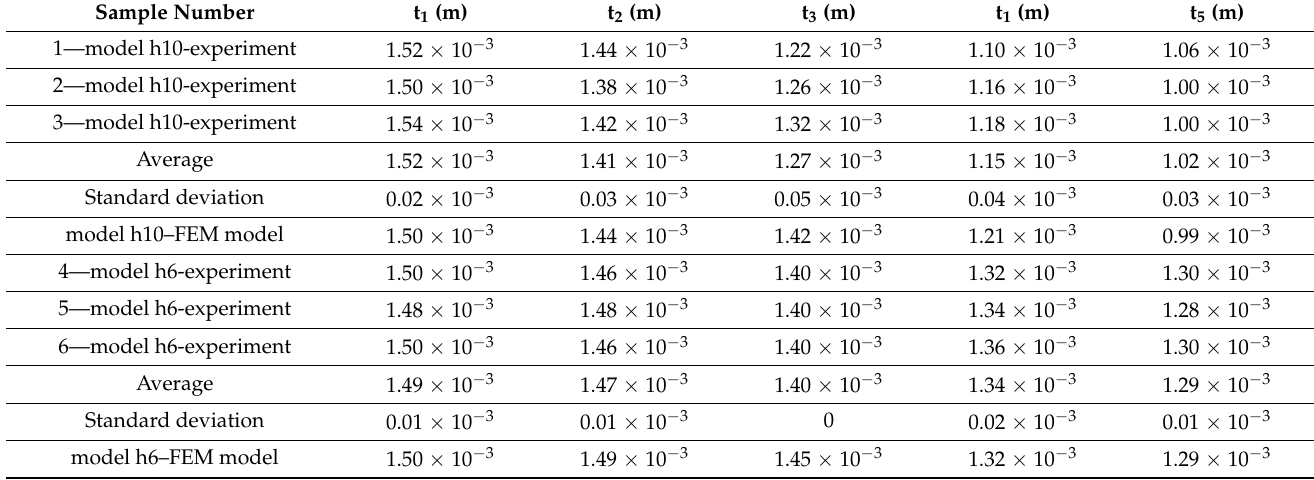
Table 3. Measurement results of the wall thickness of the drawpiece with accuracy ±0.02 × 10 − 3 (m) and obtained from the finite element method (FEM) numerical analysis.